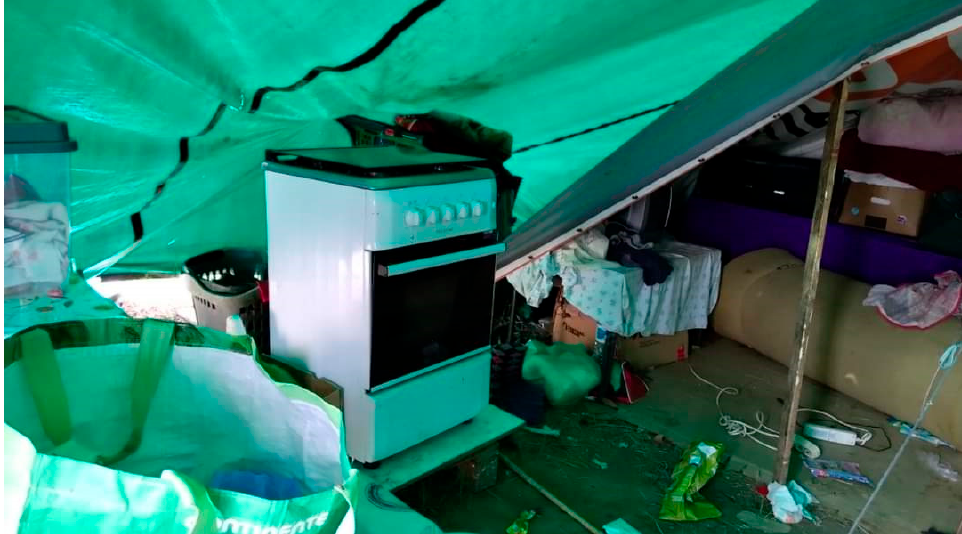
Figure 3. Cigano Camp. Photograph by Fernando Moital. January 2022.